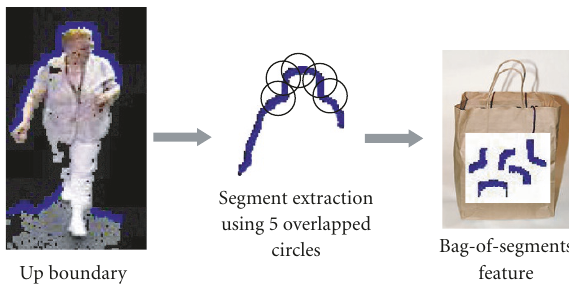
Figure 2: Feature extraction of head-and-shoulder